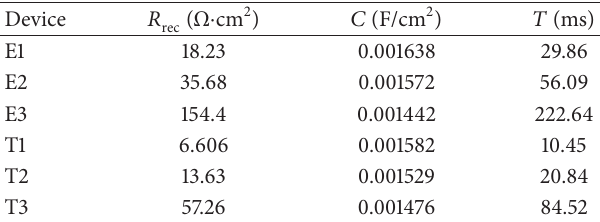
Table 3: Recombination resistance, electron life time, and the electrochemical capacity for the PT1–3 -sensitizers using EtOH and THF as dye-adsorption